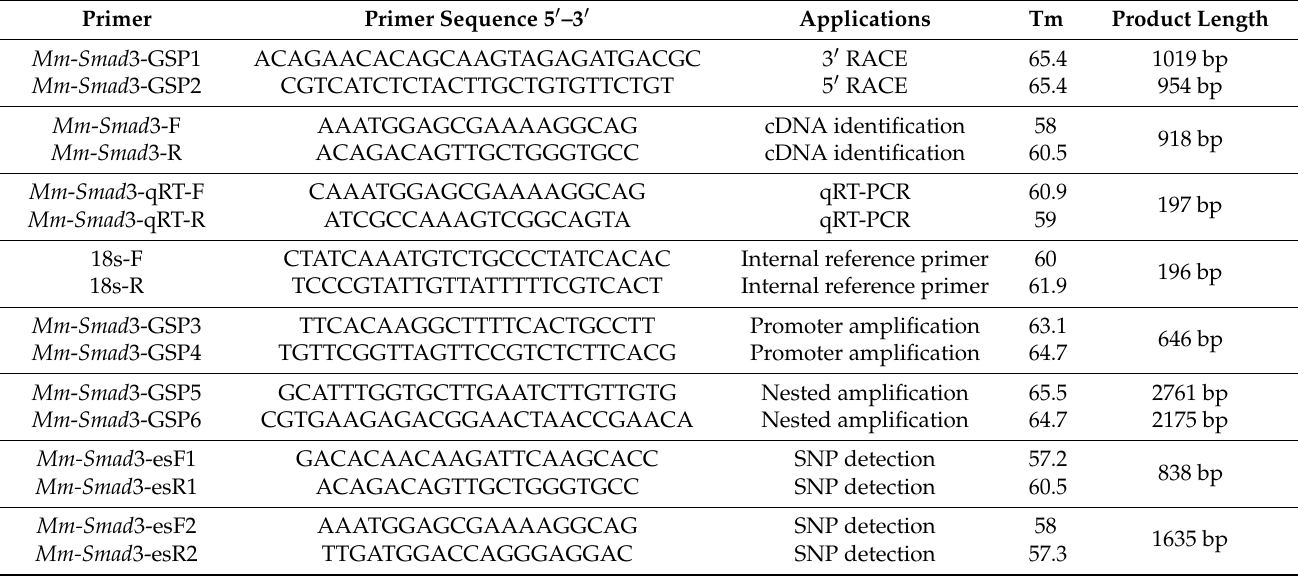
Table 1. Primers and sequences used in the